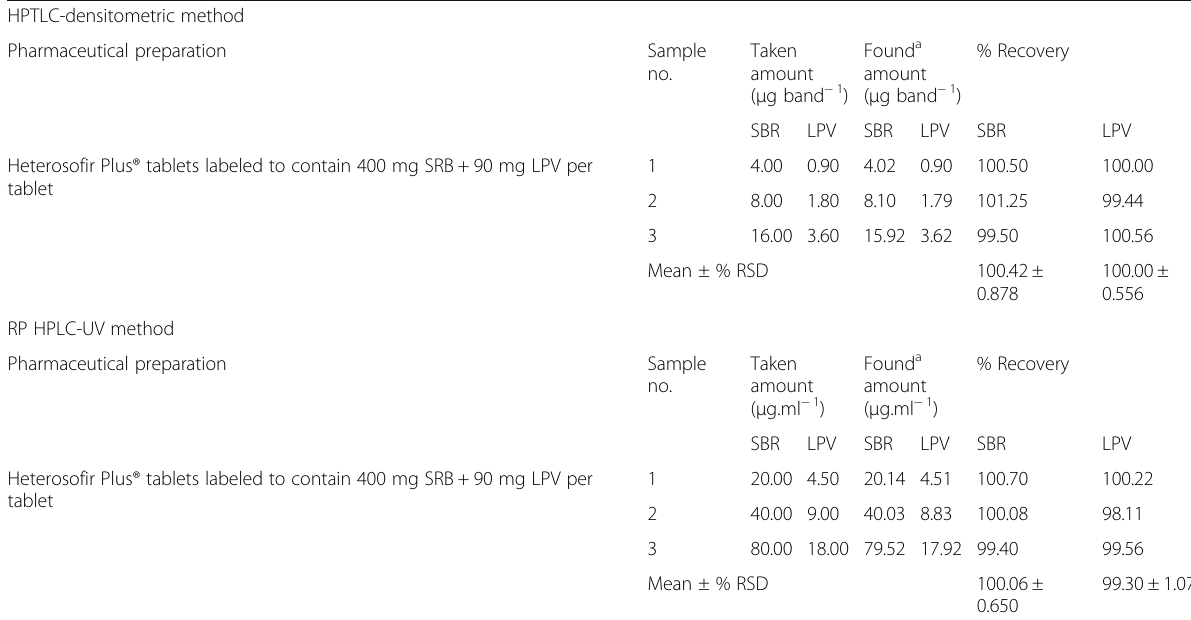
Table 5 Simultaneous estimation of SBR and LPV in Heterosofir Plus® tablets using the adopted chromatographic methods HPTLC-densitometric method Pharmaceutical preparation